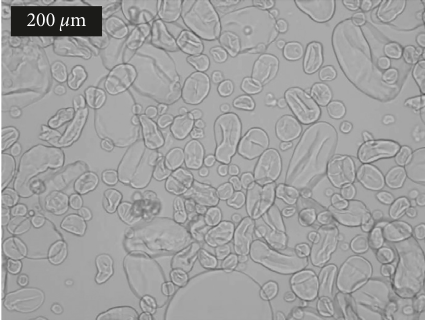
Figure 6: Optical micrograph of a hydrogel sample made by ionotropic gelation of CMS 5.6% and CaCl 2 4.9%. Scale